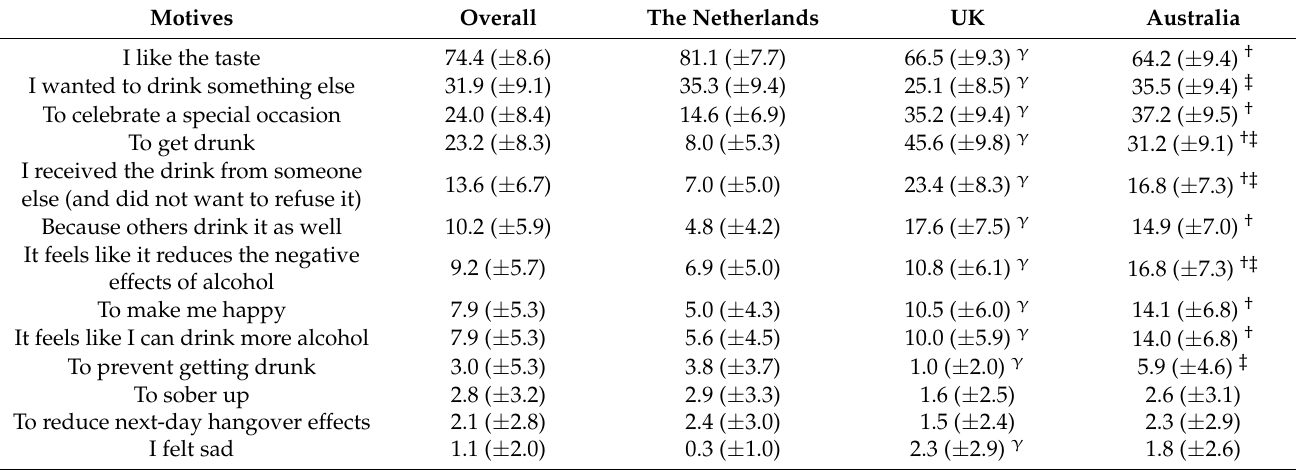
Table 2 summarized the motives for consuming AMED. Table 2. Motives for alcohol mixed with energy drink (AMED)